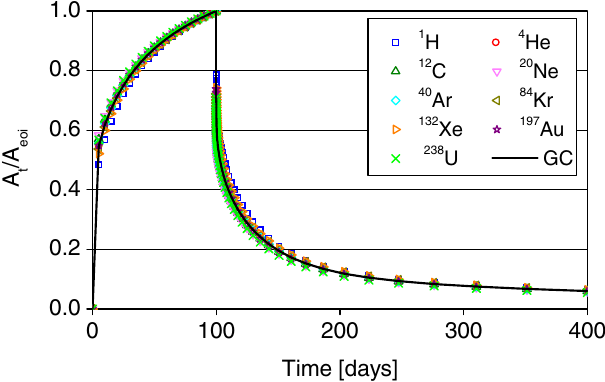
FIG. 4. (Color) Time evolution of the relative activity induced in the beam pipe by different projectiles at 500 MeV = u . A induced activity as a function of time; A eoi is the induced activity at the end of irradiation. The generic curve (GC) is obtained by averaging the data points of the individual curves corresponding to different primary ions. The relative standard uncertainty of the presented data points is less than